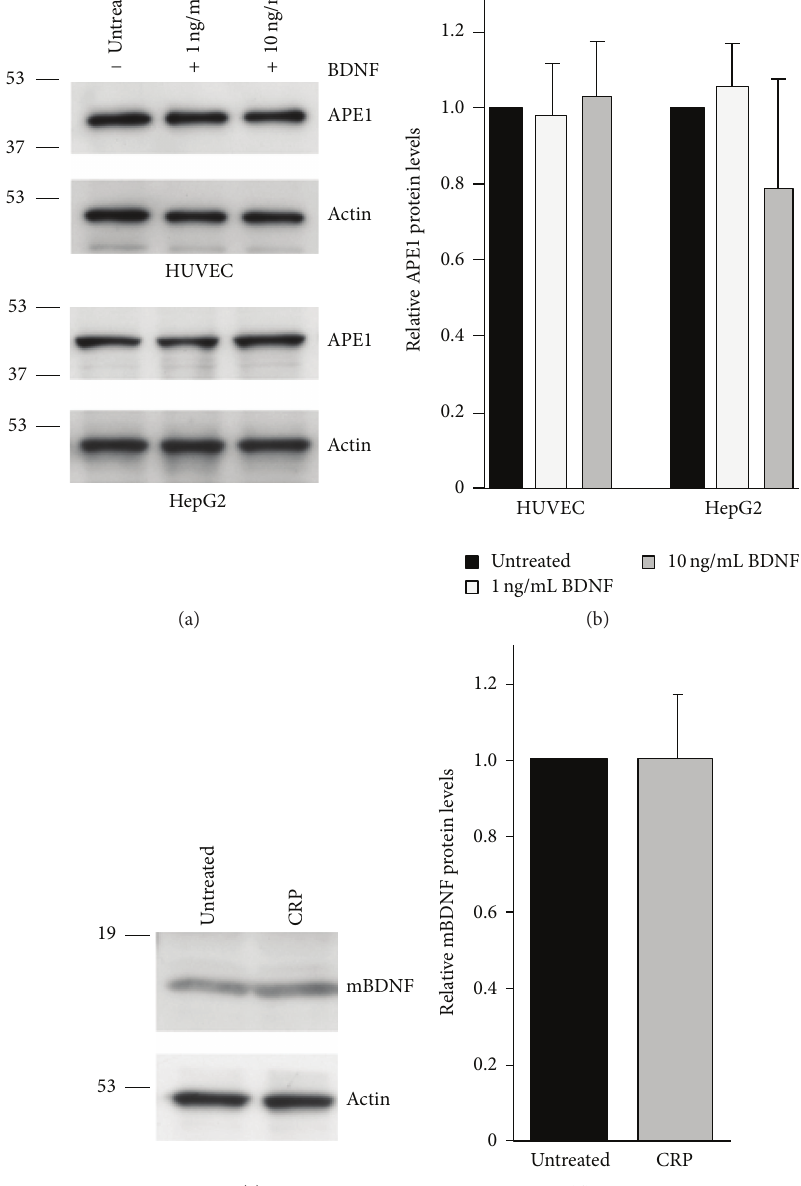
BDNF levels in endothelial cells (Figures 4(c) and